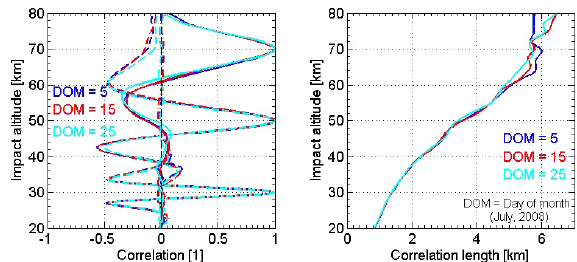
Figure 3. Global-mean error correlation functions from the back- ground error covariance matrix (left), for the 5, 15, and 25 July 2008 at three representative impact altitude levels (30, 50, and 70km), and estimated correlation lengths of the correlation functions (right) at all impact altitude levels from 20 to 80km for the same 3